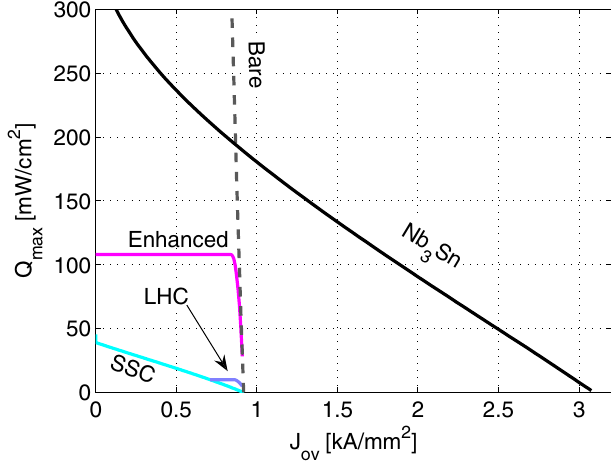
FIG. 8. (Color) Maximum heat flux from Nb-Ti (with insulation: LHC, SSC, enhanced; and without insulation: bare) and Nb coils versus overall current density at a magnetic field of 9 T.